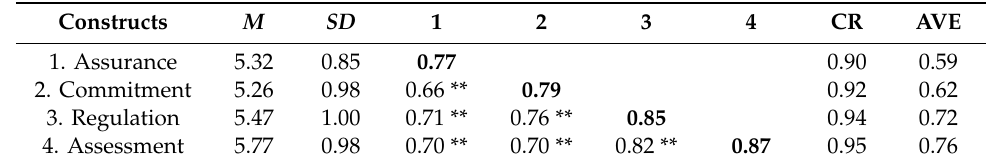
Table 7. Results of correlation, reliability, and